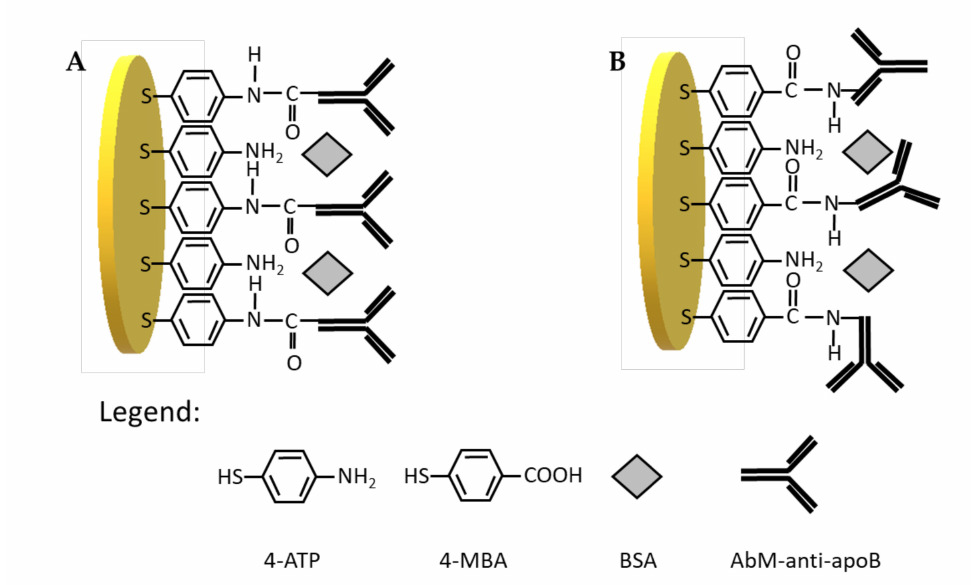
Scheme 1. Schematic illustration of antibody immobilization on the gold electrode surface using ( A ) 4-ATP linker: Au/S(C 6 H 4 )NH-CO-AbM-anti-apoB/BSA and ( B ) 4-MBA linker: Au/S(C 6 H 4 )CO- NH-AbM-anti-apoB/BSA.